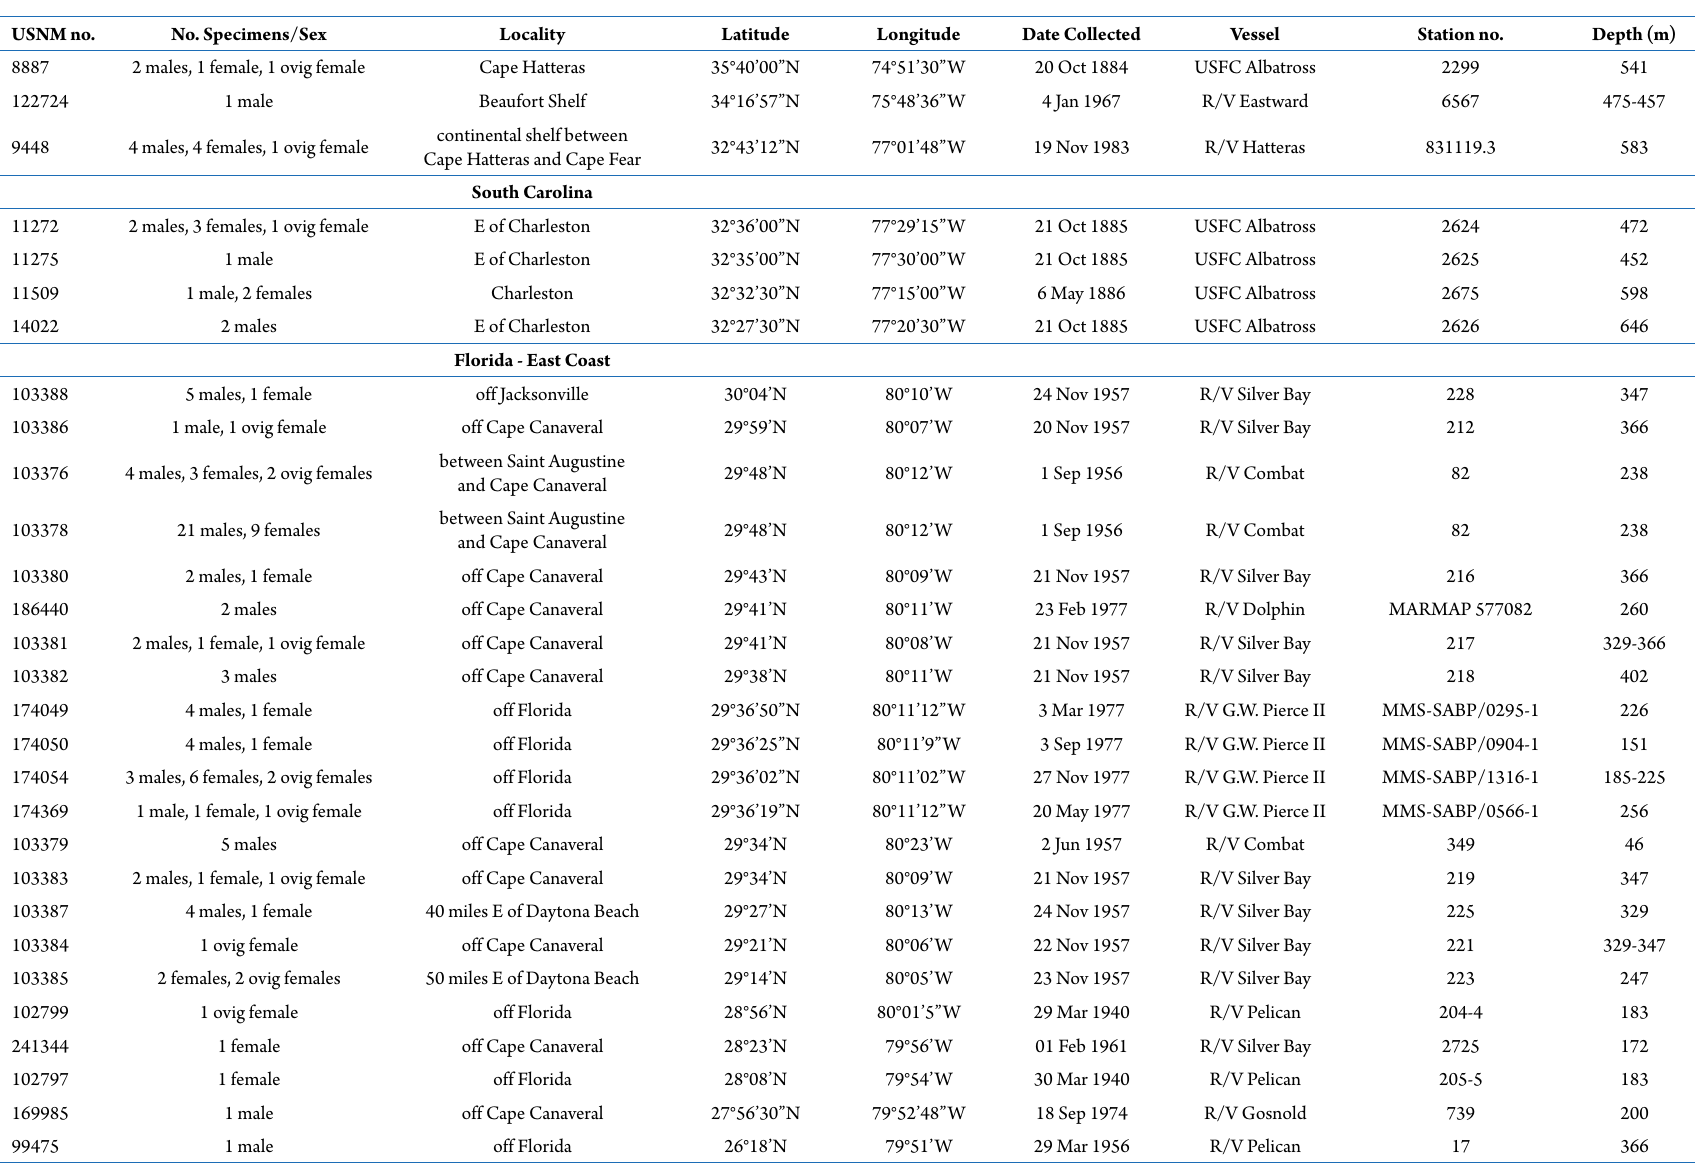
Table 1. Cont. USNM